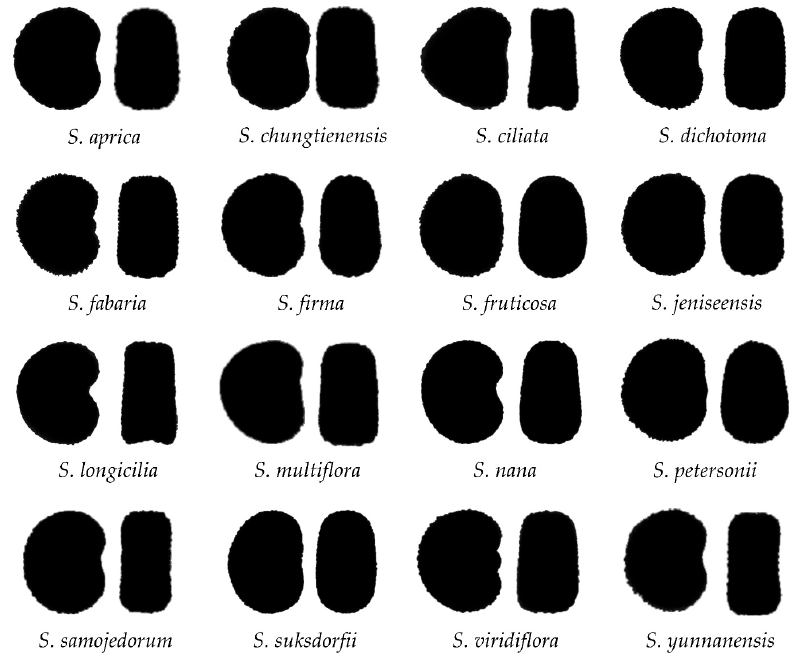
Figure A4. Average silhouettes for the lateral and dorsal views of species in the echinate group.